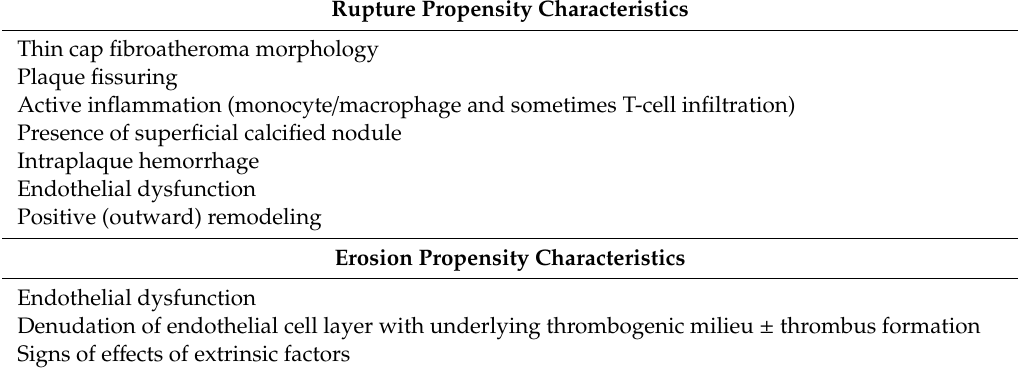
Table 1. High-risk features of “Vulnerable”